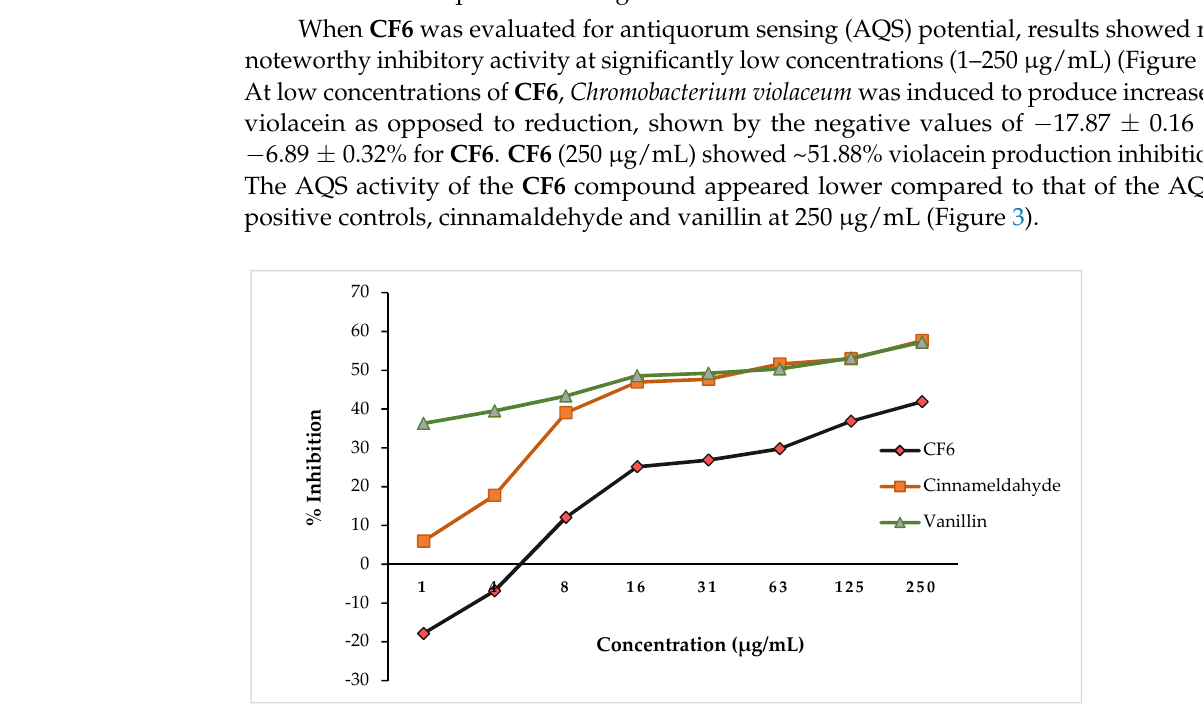
Table 3. Inhibition of cell attachment and biofilm development (at respective MIC values) on selected pathogens following exposure to CF6 .